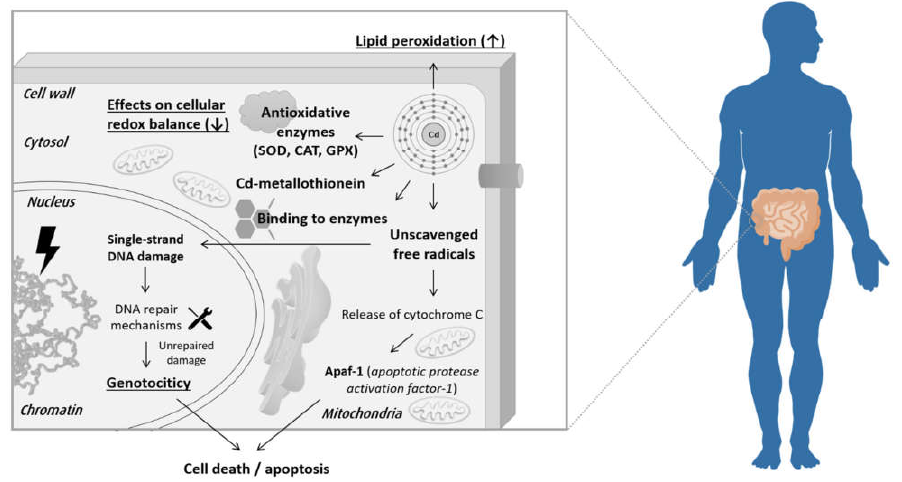
Figure 1. Overview of molecular mechanisms of cadmium toxicity and detoxication pathways in humans (based on [10]). Pathomechanism of Cadmium Toxicity